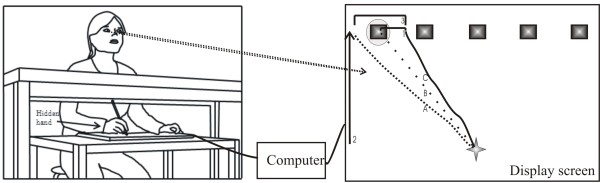
illustrates the experimental setup. The display screen shows the 6 objects, which of one is the visual object (in the lower center) and one is the hit target (the object marked with a circle). The pen-tablet and the display screen are connected to a computer, which collects the information about the trajectories of the visual object and the actual produced movement on the tablet. Explanation of the letters and numbers inside the display screen: A: the trajectory of the visual object, B: the direct path of the visual object to the target, C: the trajectory of the actual produced line on the tablet. 1: indicates the hit-distance, 2: illustrates the time it takes to move the visual object to the hit target, 3: specifies the drift of the actual movement (C) on the basis of the trajectory of the visual object (A). There are no lines visible on the display screen during the experiment.